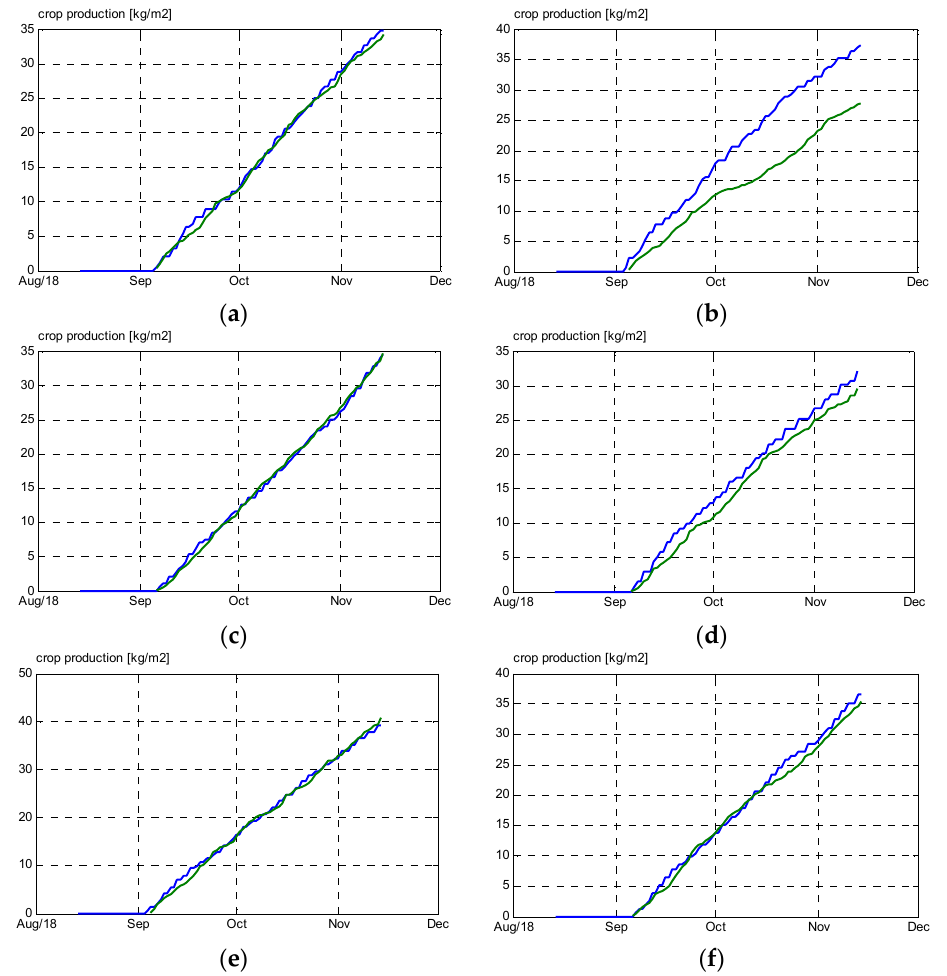
Figure A5. Validation results of modeled and realized crop production using realized climate setpoints and crop management strategies as input for model simulation for 5 teams: ( a ) iGrow, ( b ) deep_greens, ( c ) Grower = reference, ( d ) AiCU, ( e ) Sonoma, ( f ) The Croperators.